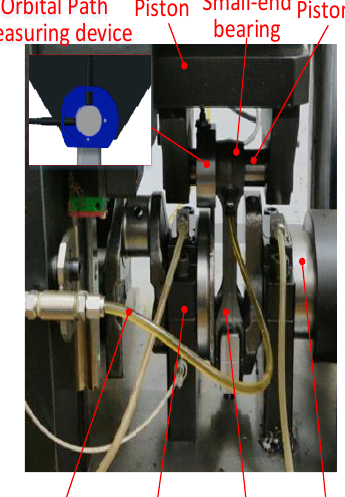
Figure 2. Structure of the test module. Table 1. Structural parameters of the test rig.